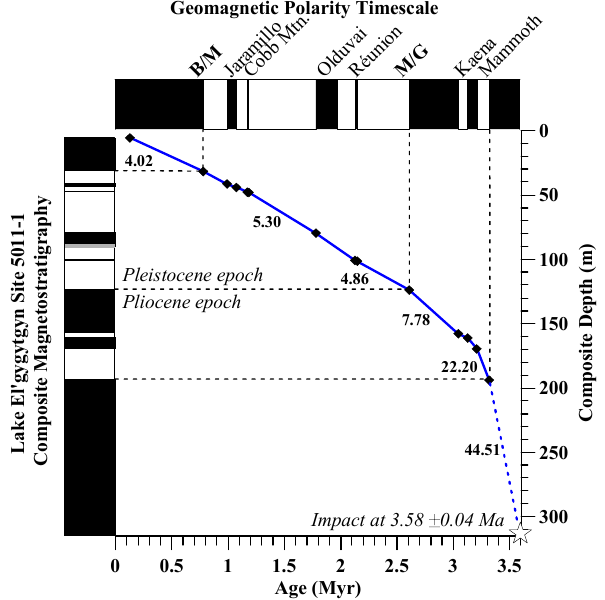
Fig. 14. Age–depth curve of the composite record (in blue) based on stratigraphical tie points (black diamonds) provided by the mag- netostratigraphy. Age of the impact (Layer, 2000) denoted with a star forms an additional chronological tie point. Numbers in boxes refer to sedimentation rates (cmkyr − 1 ) in different intervals of the composite